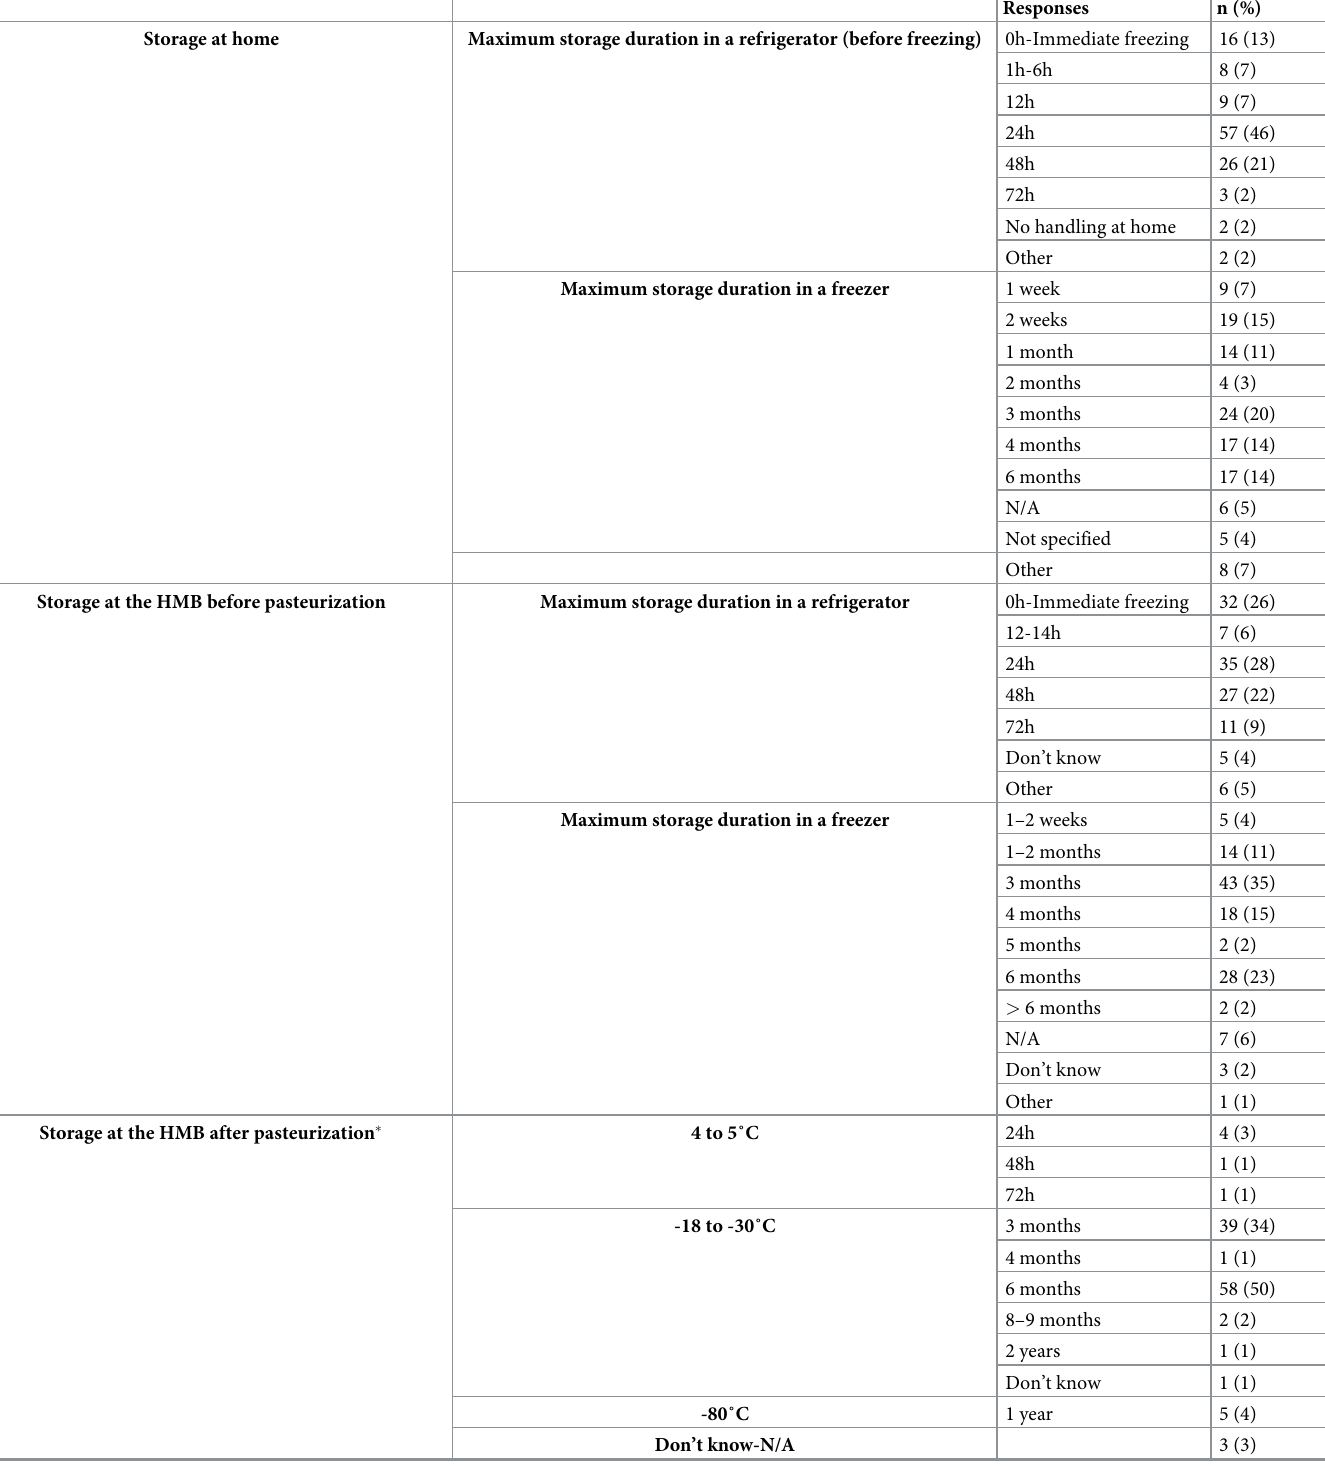
Table 2. Maximum DHM storage duration at home and at the HMB, before and after pasteurization (n =